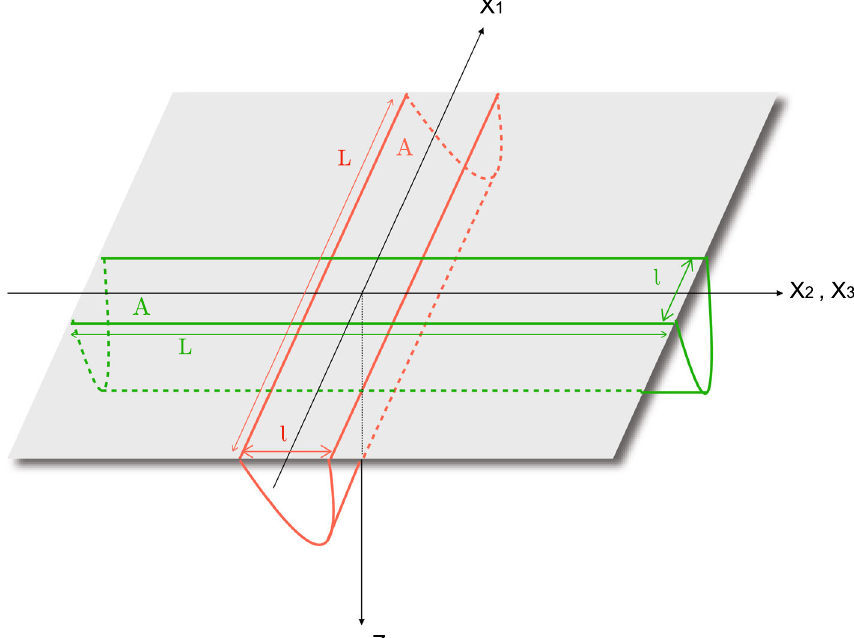
Fig. 2 Parallel minimal surface (green) and perpendicular minimal surface